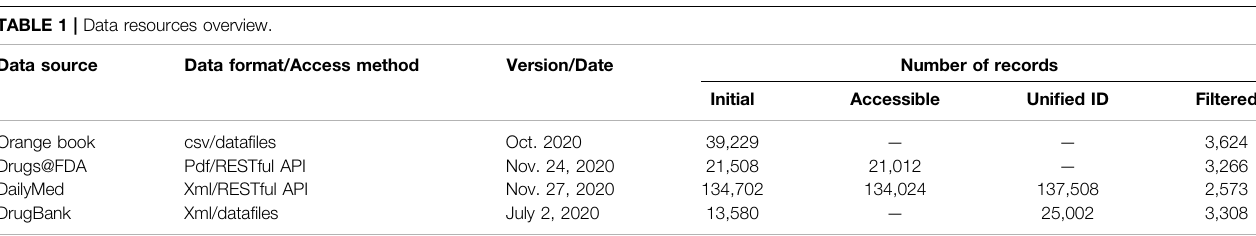
TABLE 1 | Data resources